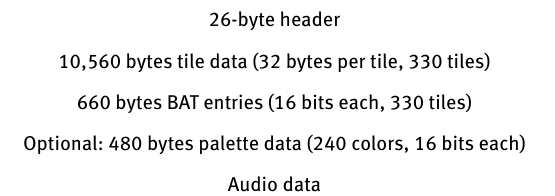
Table 2. SH FMV segment